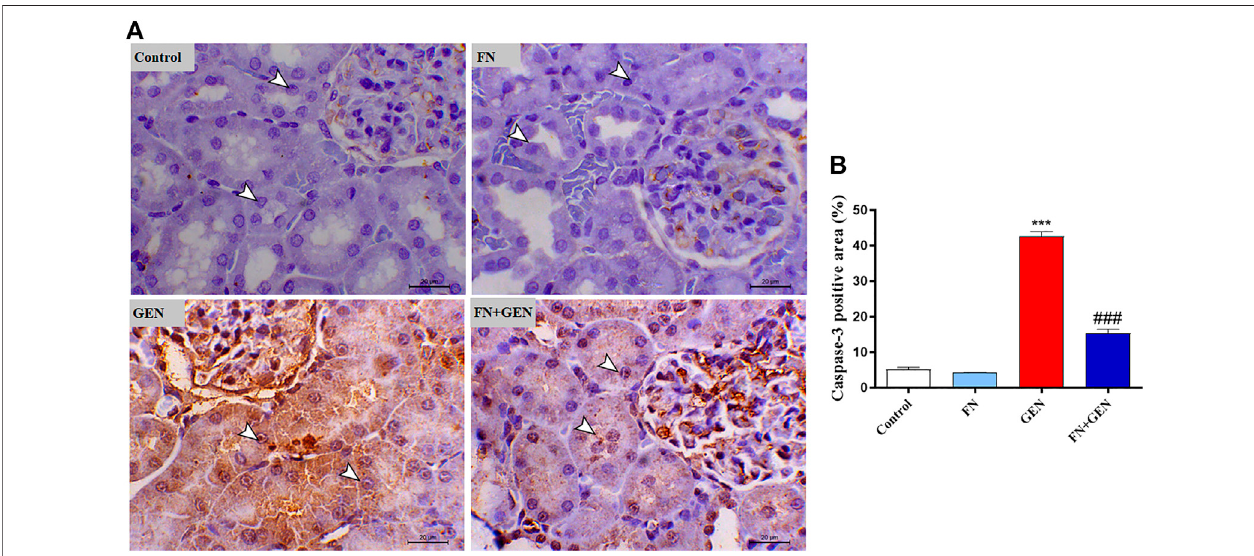
FIGURE 8 | FN downregulates renal caspase-3 in GEN-intoxicated kidney. (A) Photomicrographs of renal sections from control rats and FN-treated rats demonstrating a low level of caspase-3 expression within the tubular epithelia (arrowheads), GEN-treated animals showing marked cytoplasmic and nuclear expression ofcaspase-3withintherenaltubules(arrowheads),andGEN-administeredratspre-treatedwithFNdemonstratinganoticeabledecreaseintheexpressionofcaspase-3 withinthetubularepithelia (arrowheads) (IHC, X200,scale bar=20 µm). (B) Image analysisofcaspase-3immunostaining inthekidneyofratsshowingasigni fi cant increase in GEN-administrated rats and a signi fi cant decrease in FN-treated animals. Results are mean ± SEM ( n = 6). ppp indicates p < 0.001 versus control, and ### indicates p < 0.001 versus GEN. FN: formononetin; GEN: gentamicin.